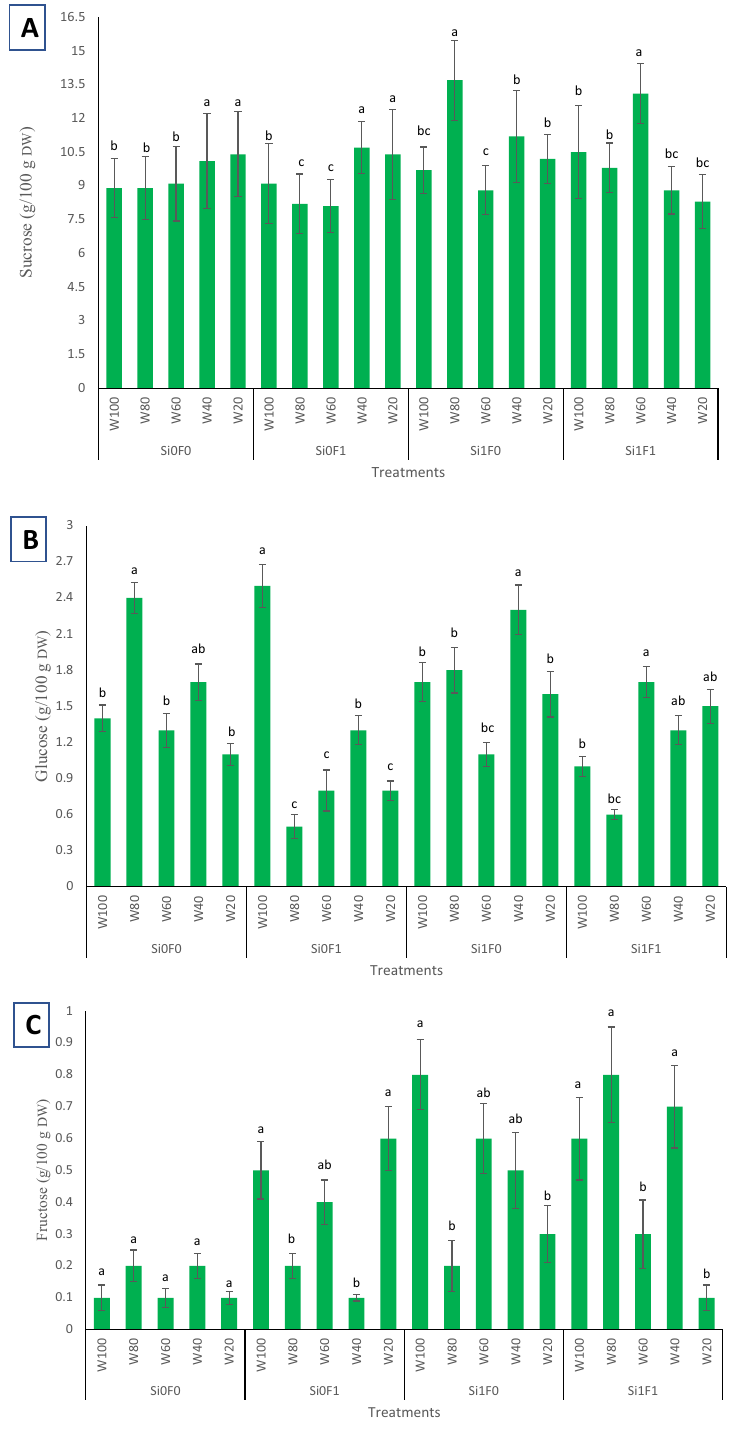
Figure 2. HPLC analysis of ( A ) sucrose, ( B ) glucose and ( C ) fructose among drought stress, Si application and mycorrhiza inoculation interactions in examined Licorice plants. According to the analysis of variance that triple effects of fungi, drought levels and Si showed significant difference, slice method used for mean comparisons. Mean values with the same letters are not significantly different in each treatment ( p < 0.05), Tukey test. W stands for water deficit treatment (5 levels including 100% (W100), 80% (W80), 60% (W60), 40% (W40), and 20% (W20) of field capacity), Si stands for silicon application (two levels including Si0 (no Si application) and Si1 (Si application)) and F stands for mycorrhiza inoculation (two levels including F0 (no inoculation) and F1